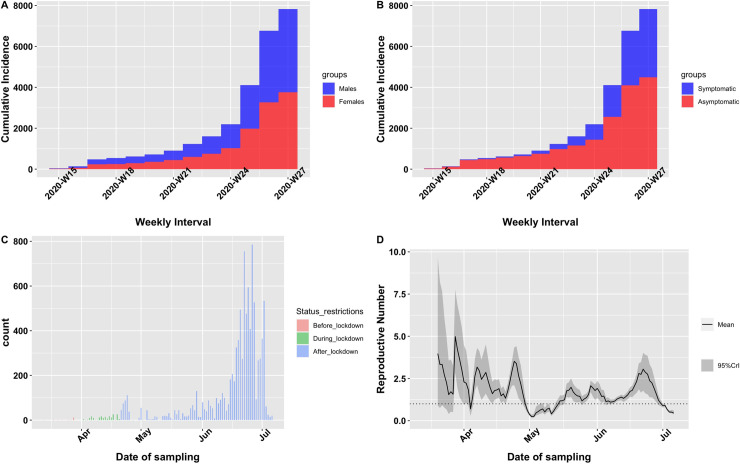
Epidemiological profile of SARS-CoV-2 infections.